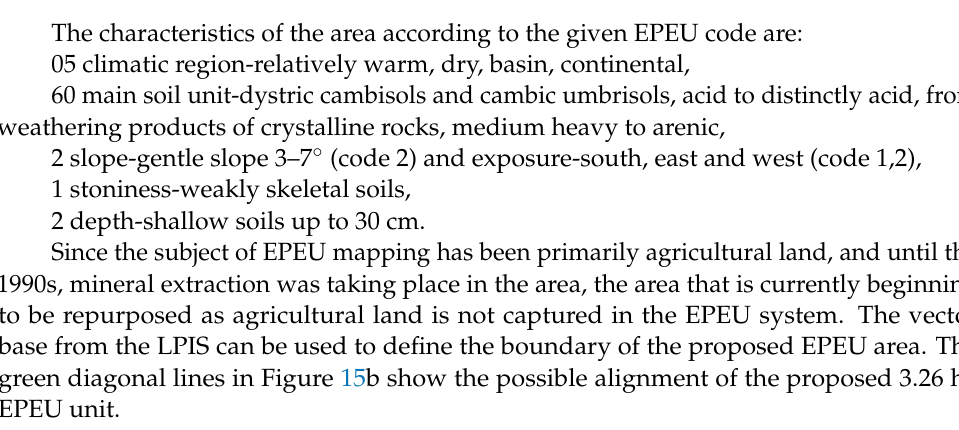
Figure 15. EPEU layers and LPIS use boundaries; ( a ) existing EPEU status ; ( b ) proposed EPEU area.